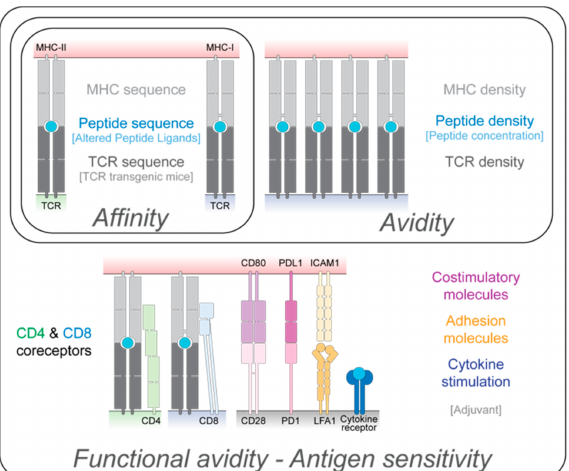
Figure 1. Factors that influence the affinity, avidity, and functional avidity of T cells. T cell receptor (TCR) affinity is defined by the strength of an interaction between a single TCR and a given peptide presented by a major histocompatibility complex (MHC) molecule. It depends on the amino acid sequence of the TCR, the sequence of the peptide being presented, and the MHC allele. TCR avidity is dependent on both the affinity of a single TCR molecule for a given pMHC and the number of TCR-pMHC engagements. Functional avidity, also known as antigen sensitivity, considers also the influence of co-receptors, co-signaling molecules, adhesion molecules, and cytokines that might influence the overall intensity and duration of the TCR signal. Multiple approaches (in brackets) can be used to manipulate the different parameters to influence TCR signal